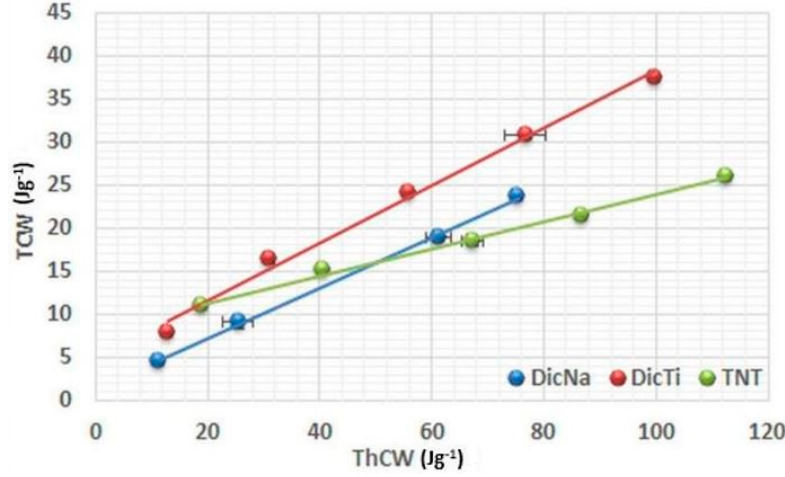
Figure 7. Evolution of net energy (NCW) with TCW of TNT, DicNa and DicTi at 50, 100, 150, 200 and Figure 6. Evolution of total energy (TCW) with theoretical energy (ThCW) of TNT, DicNa and DicTi at 250 MPa compression pressure. 50, 100, 150, 200 and 250 MPa compression Table 2. Energetic parameters of titanate nanotubes (TNTs), active pharmaceutical ingredients (APIs) and TNT–API composite powders.